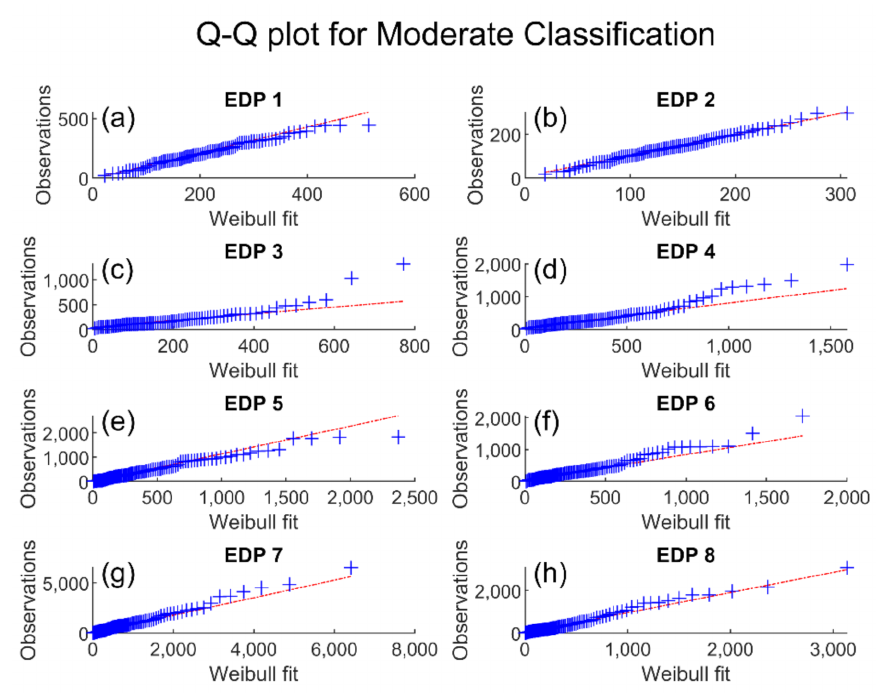
Figure 7. Weibull distribution quantile plots for all observations corresponding to Moderate classifica- tion. ( a ) EDP 1—Berm Width; ( b ) EDP 2—Berm and Dune width; ( c ) EDP 3—Dune Volume; ( d ) EDP 4—Foredune Volume; ( e ) EDP 5—Shear; ( f ) EDP 6—Moment; ( g ) EDP 7—Simplified Mass-moment of Inertia; ( h ) EDP 8—Mass-moment of Inertia.